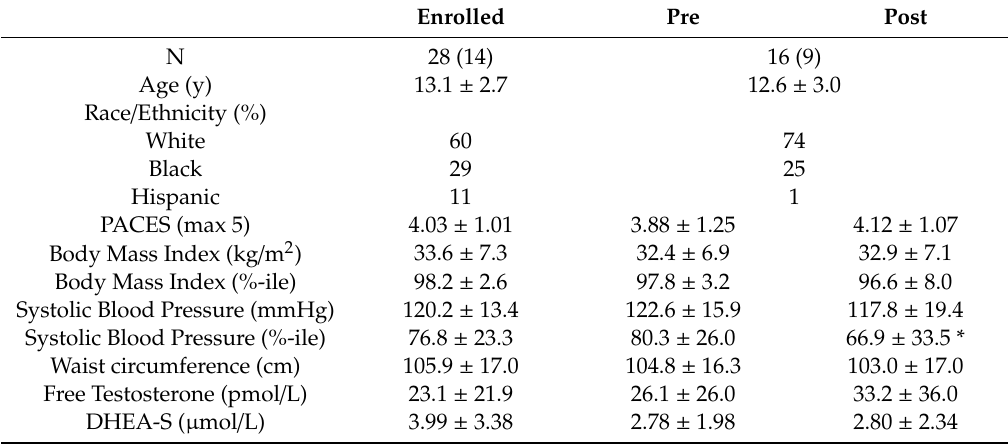
Table 1. Baseline and post-program subject